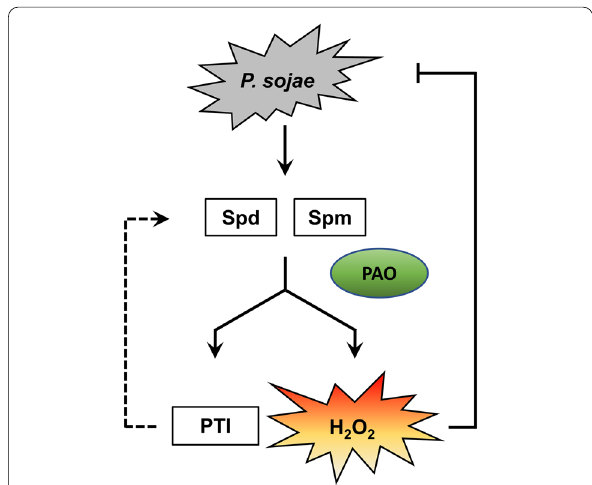
Fig. 8 A proposed model illustrating the mechanism of GmPAO-mediated resistance. The two substrates Spd and Spm are increased upon P. sojae infection. GmPAO-mediated Spd/Spm catabolism enhances H 2 O 2 production and PTI activation, thereby controlling the infection caused by P. sojae . The activation of PTI response might promote the increase of Spd and Spm contents